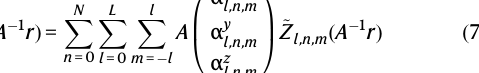
completely cancel the Z component on the rotated coef fi cients, as they only con- tribute to the over-deformation of the deformed map. This leads to the set of coef fi cients α 00 r ð Þ . c The modi fi ed coef fi cients are rotated back to the original l , n , m ( r )are positionde fi nedbythemap ’ sgrid.Inthisway,anewsetofcoef fi cients α 00 l , n , m obtained, de fi ning a deformation fi eld consistent along the projection direc- tion ( X